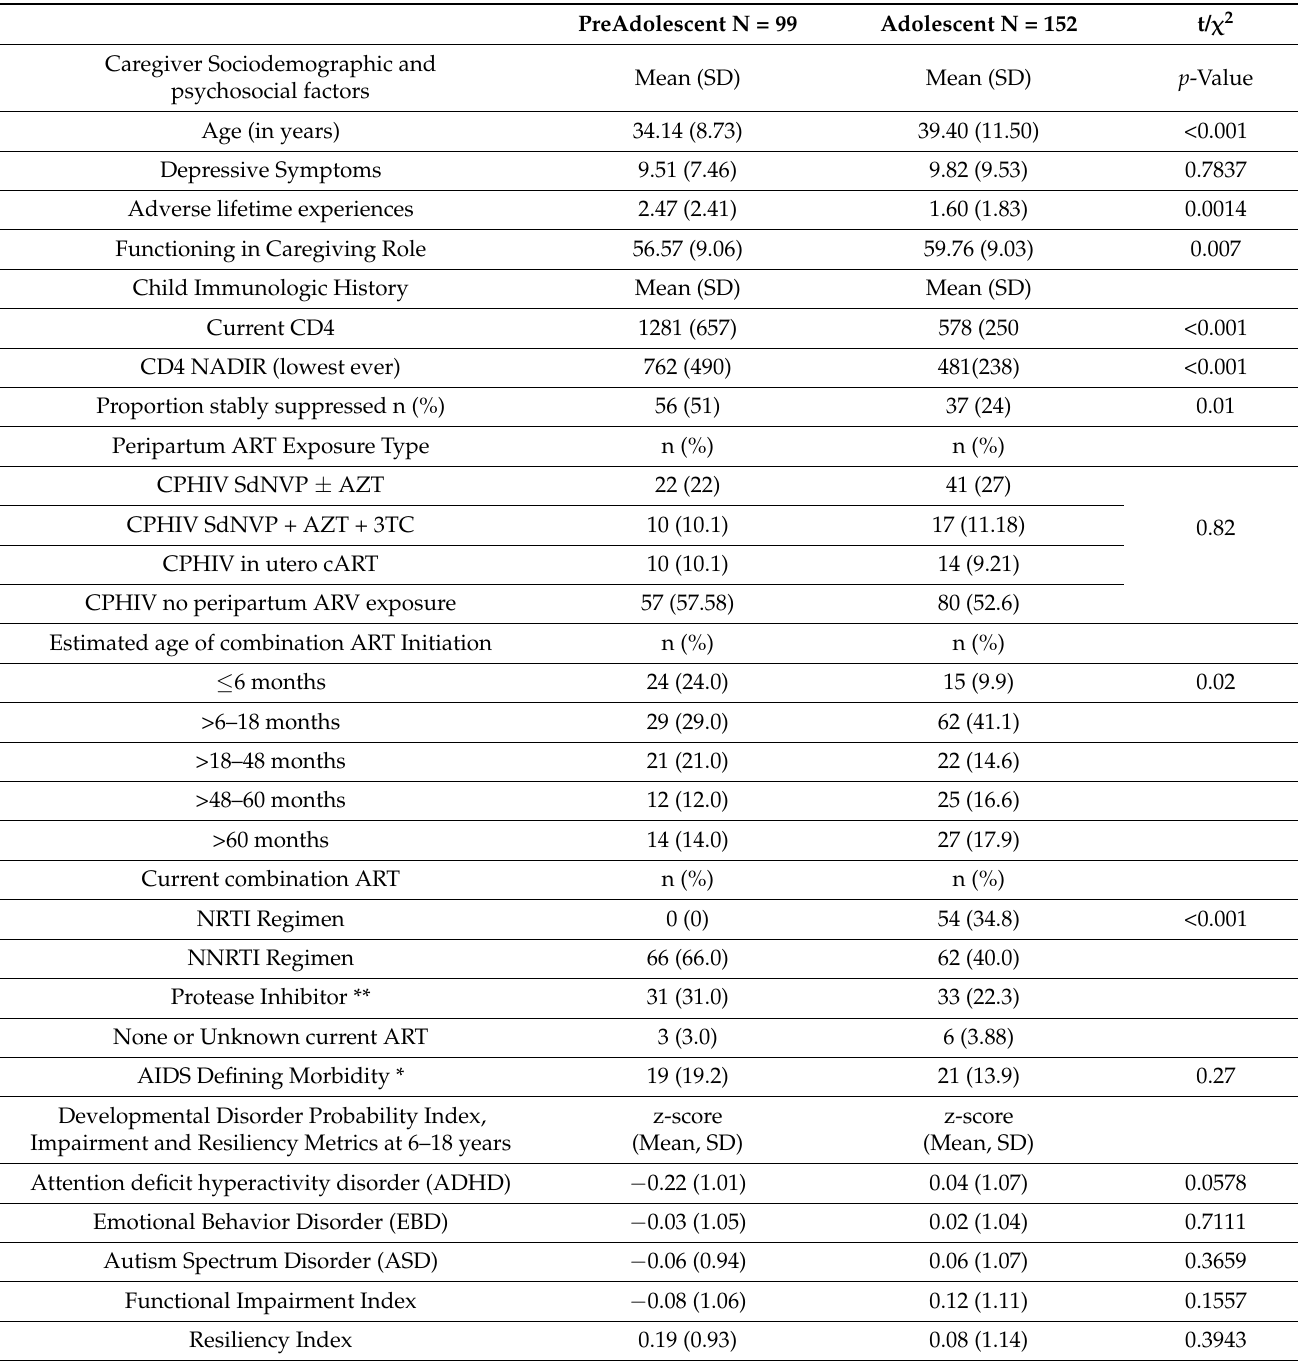
Table 2. Description of caregiving context, child immunologic and HIV treatment parameters among perinatally HIV-infected children according to developmental